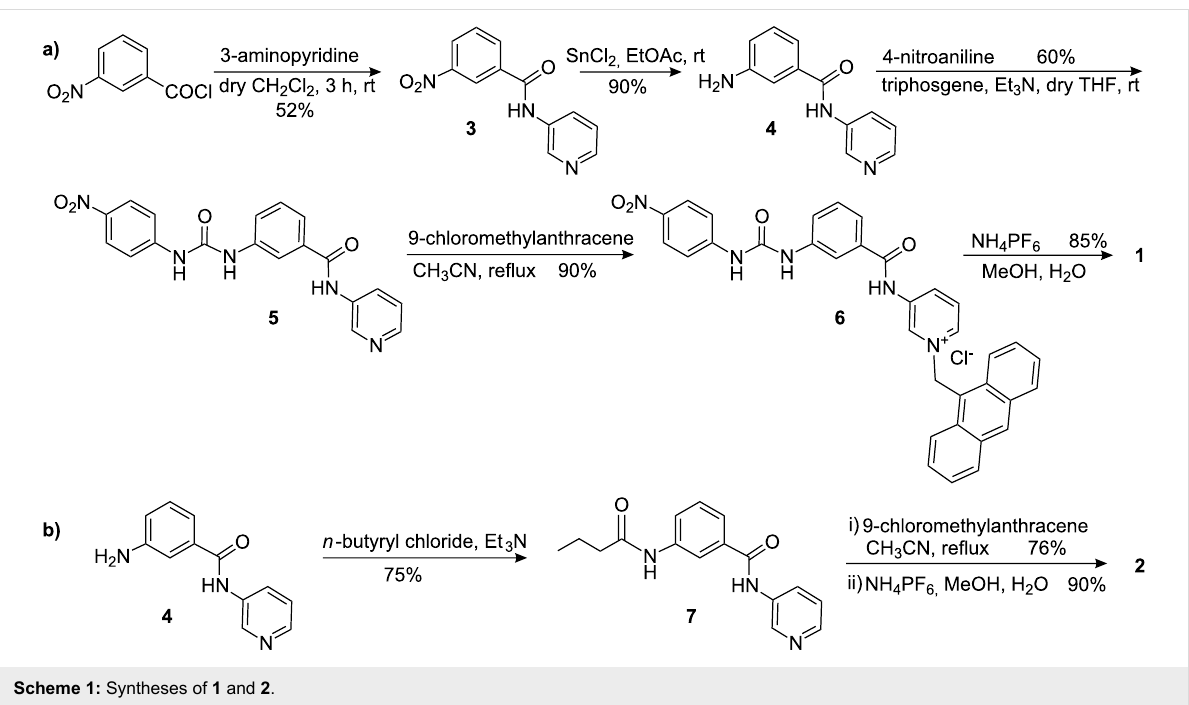
guests exhibit minimal solubility. Hamilton et al. introduced simple pyridine amide-based receptors for the effective recogni- tion of N -acetyl- α -amino acids by multiple hydrogen bonding interactions [20]. During our work on selective recognition of different anionic species including carboxylates [21,22],